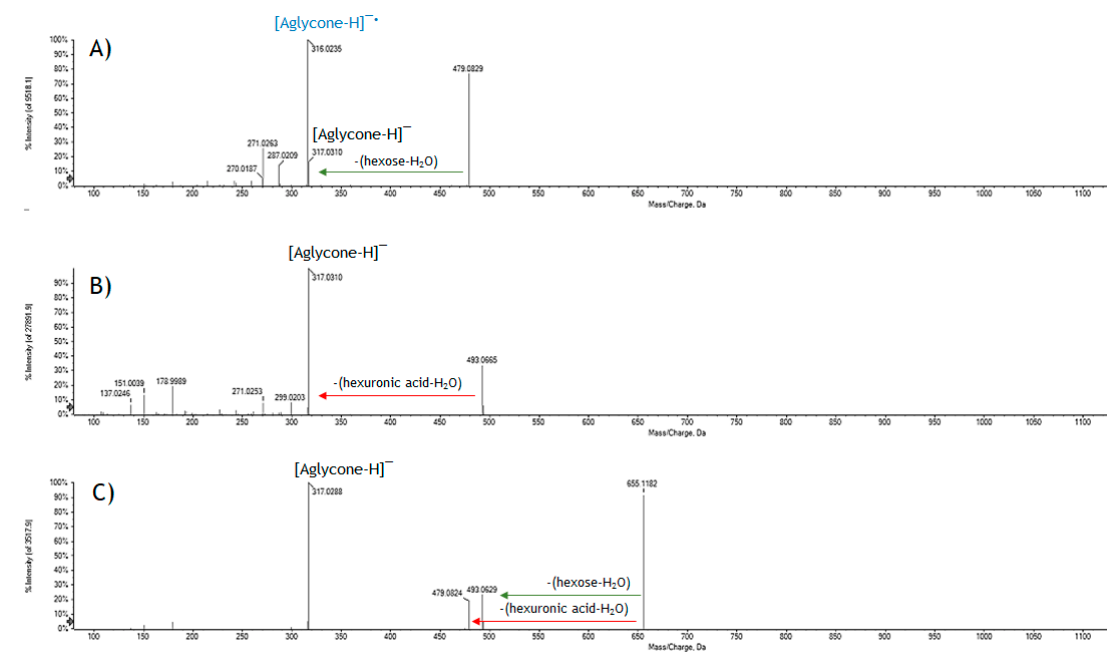
Figure 4. TOF-MS 2 spectra of metabolites ( A ) 5 ; ( B ) 6 ; and ( C ) 9 .